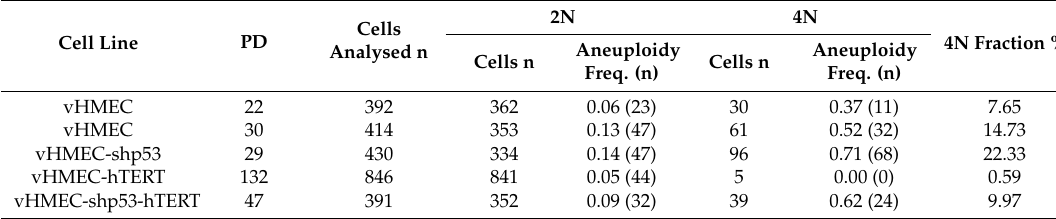
Table 3. OligoFISH analysis of centromeric specific probes for chromosome 6, 12 and